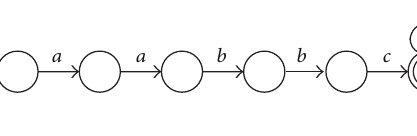
Figure 4: Finite automaton accepting 𝑃 1